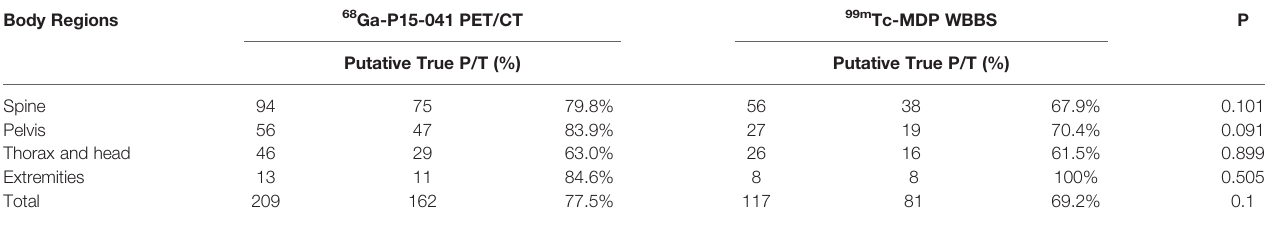
TABLE 5 | Location and Number Diagnosis of the Skeletal Lesions in 68 Ga-P15-041 PET/CT and 99m Tc-MDP WBBS. Body